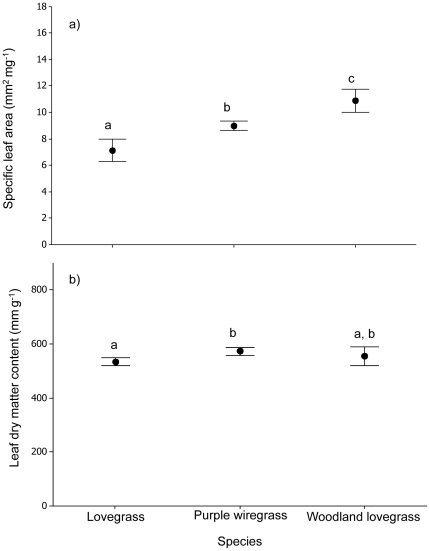
Comparison of mean trait values between species at the site level.Mean LDMC and SLA values (± S.E.) for each species for the grazing only treatment, which was the original disturbance at this site and therefore represents a control. Different letters indicate means are significantly different at p<0.05.